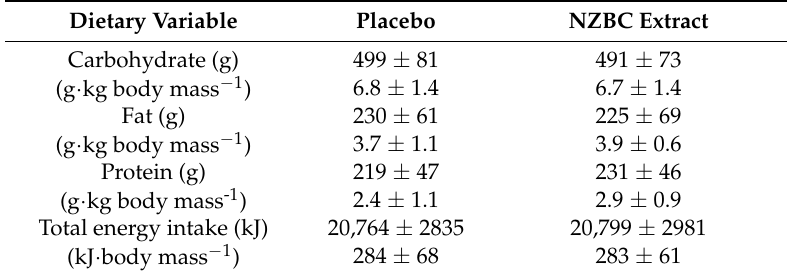
Table 1. Absolute and relative to body mass dietary intake 48 h before each visit for placebo and NZBC extract condition. Dietary Variable Placebo NZBC Extract Carbohydrate (g) 499 ± 81 491 ± 73 (g · kg body mass − 1 ) 6.8 ± 1.4 6.7 ± 1.4 Fat (g) 230 ± 61 Protein (g) 219 ±